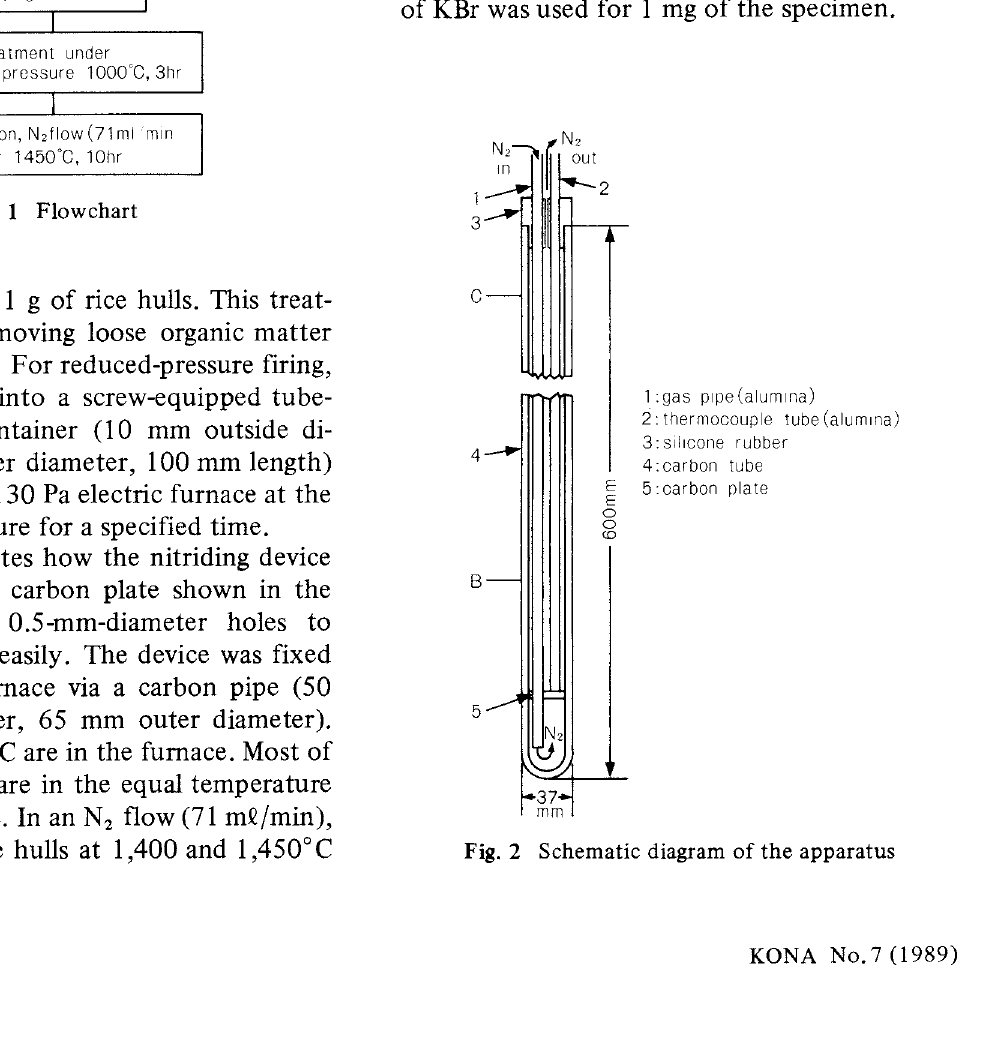
Fig. 2 Schematic diagram of the apparatus